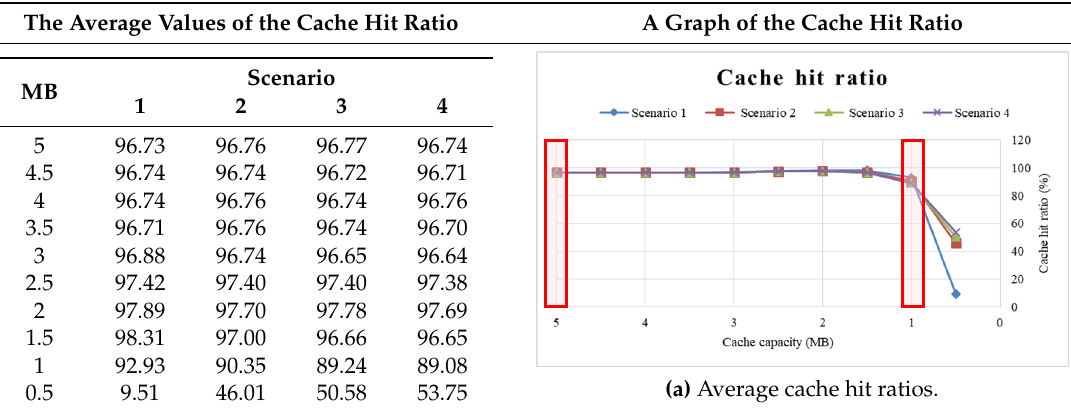
Table 7. Cache hit ratio by cache